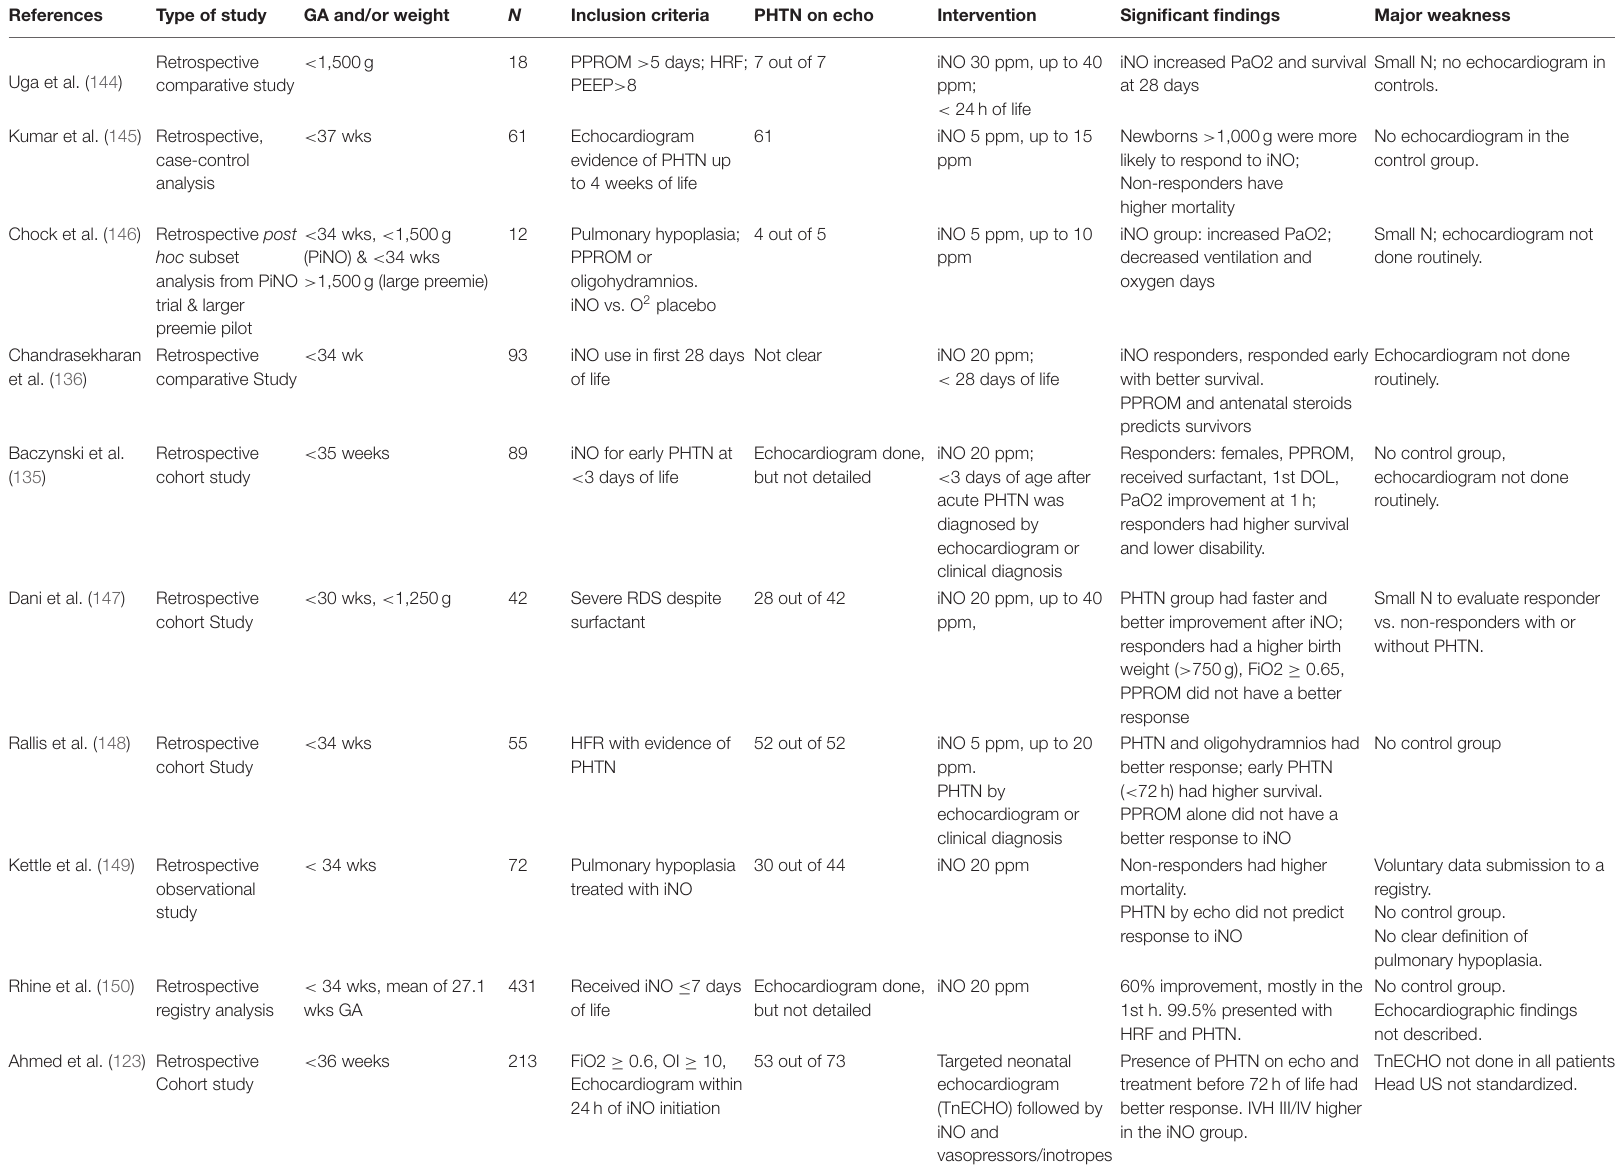
TABLE 1 | Characteristics of pre-term infants that responded to iNO